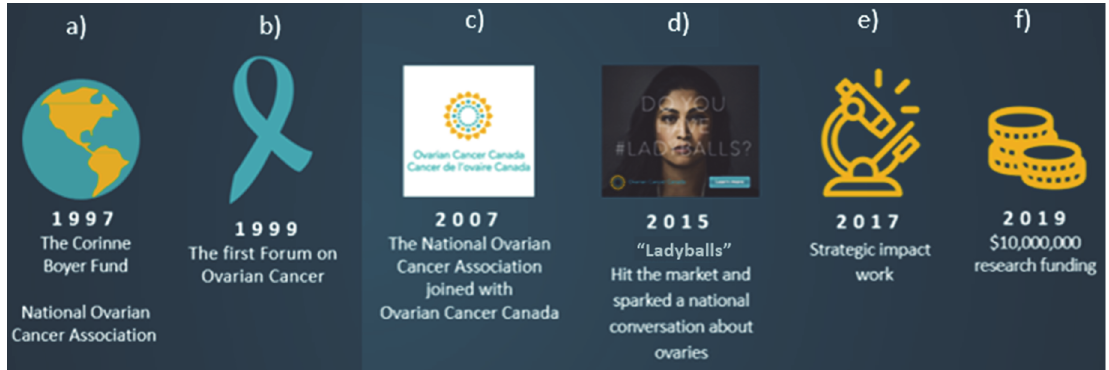
Figure 1. Twenty years of progress ( a ) The Corinne Boyer Fund is established, renamed the National Ovarian Cancer Association; ( b ) the first Forum on Ovarian Cancer; ( c ) the National Ovarian Cancer Association joined with Ovarian Cancer Canada; ( d ) “Ladyballs” national campaign launched, sparking a conversation about ovaries; ( e ) strategic impact work; ( f ) Ovarian Cancer Canada receives C$10,000,000 investment for funding ovarian cancer research.